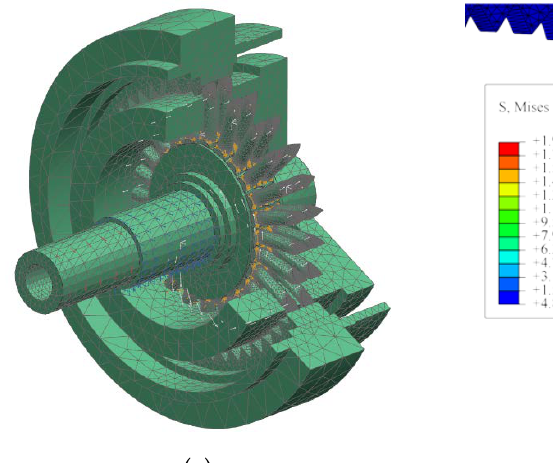
( b ) Figure 15. FEM simulation of the prototype with the two − lobe wave generator. ( a ) Grid partition; ( b ) Contact stresses of the teeth and ring gear.